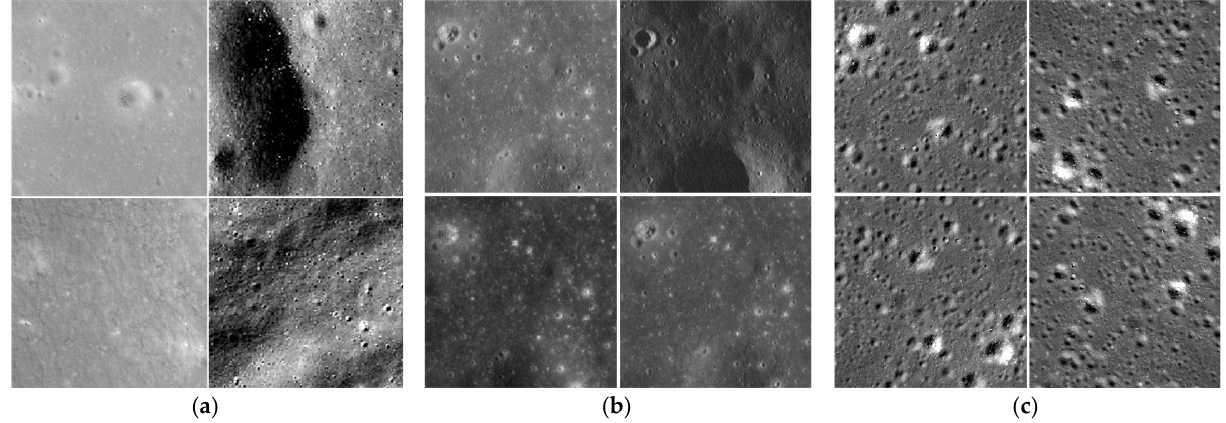
Figure 3. Examples of LROC NAC images from our training data: ( a ) images with different surface topography and features; ( b ) images with different lighting conditions in the same area; ( c ) images after rotation or flipping to simulate different sun azimuths.